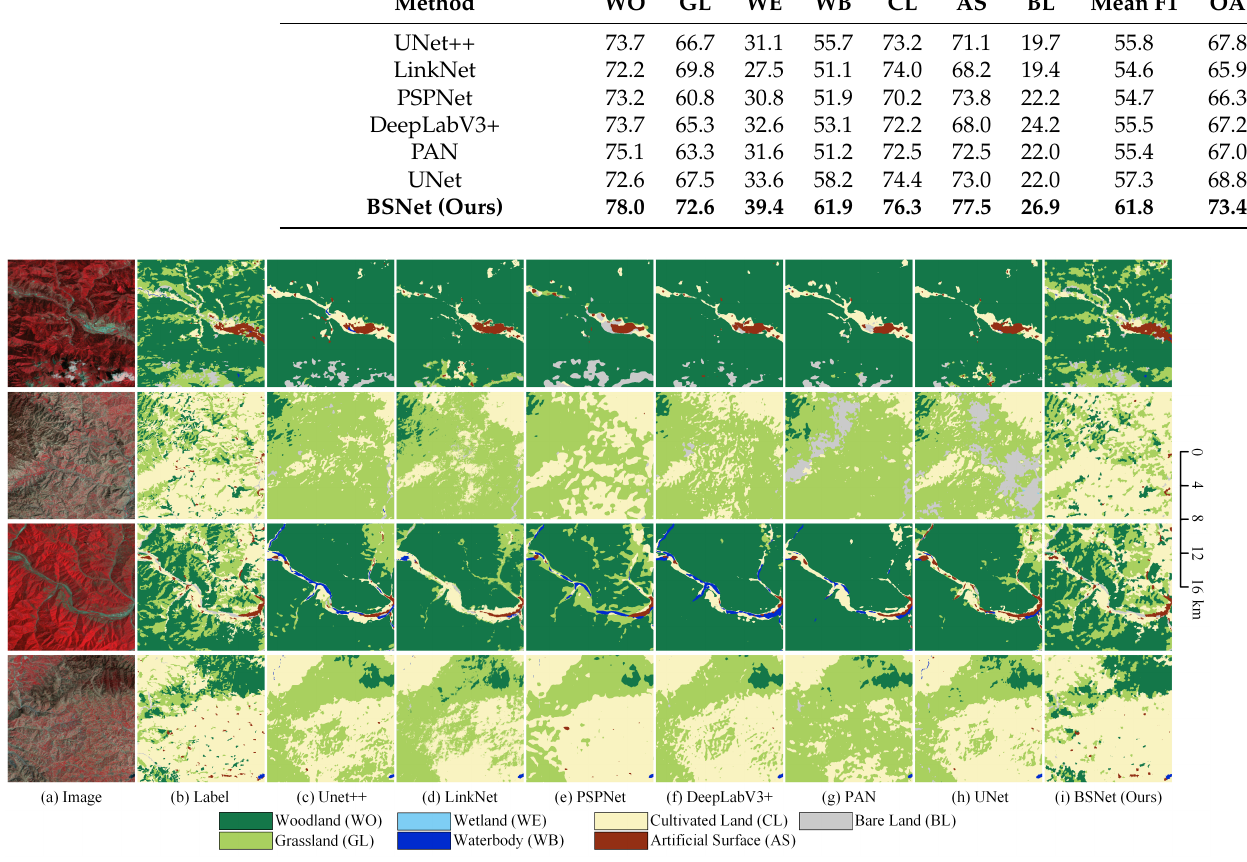
Figure 16. Some examples of the results on the Landsat supplement dataset. Comparison between our BSNet and other methods. ( a ) Landsat image. ( b ) Ground truth. Inference result of ( c ) the UNet++, ( d ) the LinkNet, ( e ) the PSPNet, ( f ) the DeepLabV3+, ( g ) the PAN, ( h ) the UNet, and ( i ) our proposed